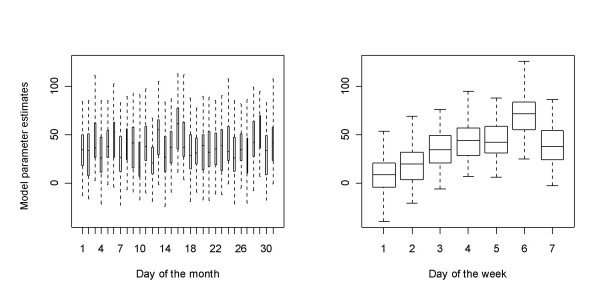
Box plots of the fitted model outputs for the generalised linear model for live cattle imports reported to BCMS over the period 1st Jan 2002 and 28th Feb 2005. (a) effect of day of the month (b) effect of day of the week (1- Sunday : 7-Saturday). Boxes incorporate the standard errors around the parameter estimate with error bars indicating the 95% confidence interval.